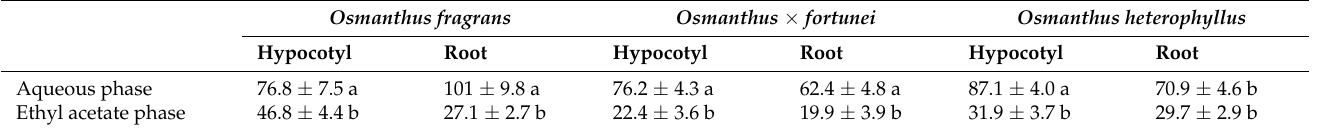
Table 2. Effects of the aqueous and ethyl acetate phase obtained after the partition of the extracts of O. fragrans , O. heterophyllus , and O. × fortunei on the growth of the hypocotyl and roots of the cress (% of control). The activity was determined using the test samples obtained from 100 mg of leaf equivalent extract/mL. Different letters in the same column indicate significant differences (Tukey’s HSD test, p ≤ 0.05).